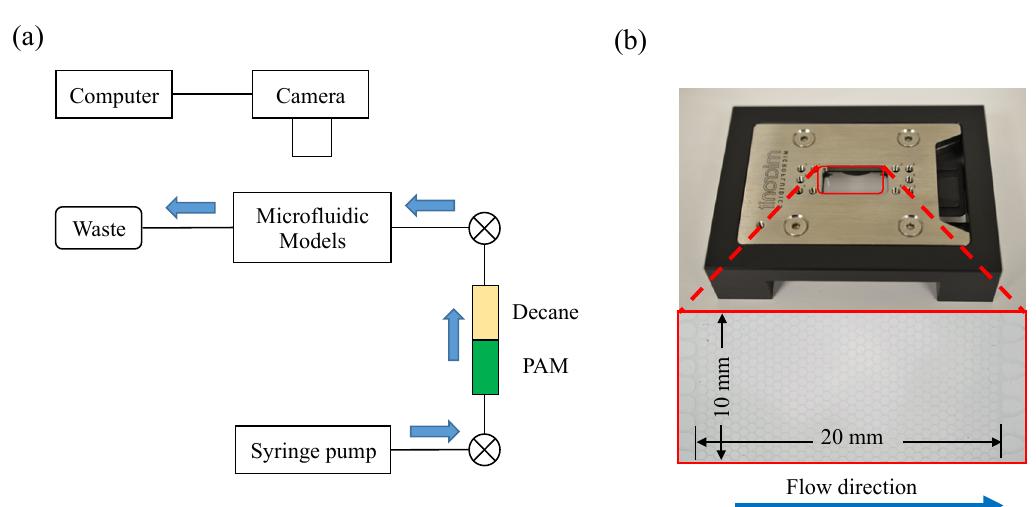
Figure 4. Micromodel test: ( a ) schematic design of the setup and ( b ) micromodel used to represent a two ‐ dimensional porous network.